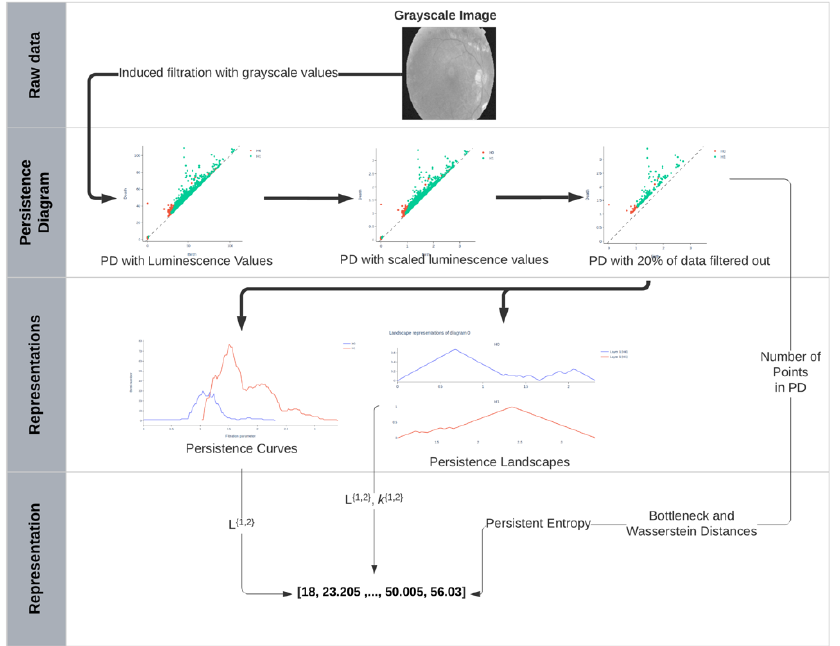
Figure 8. Representation of pipeline for extraction of topological descriptors of eye fundus images.